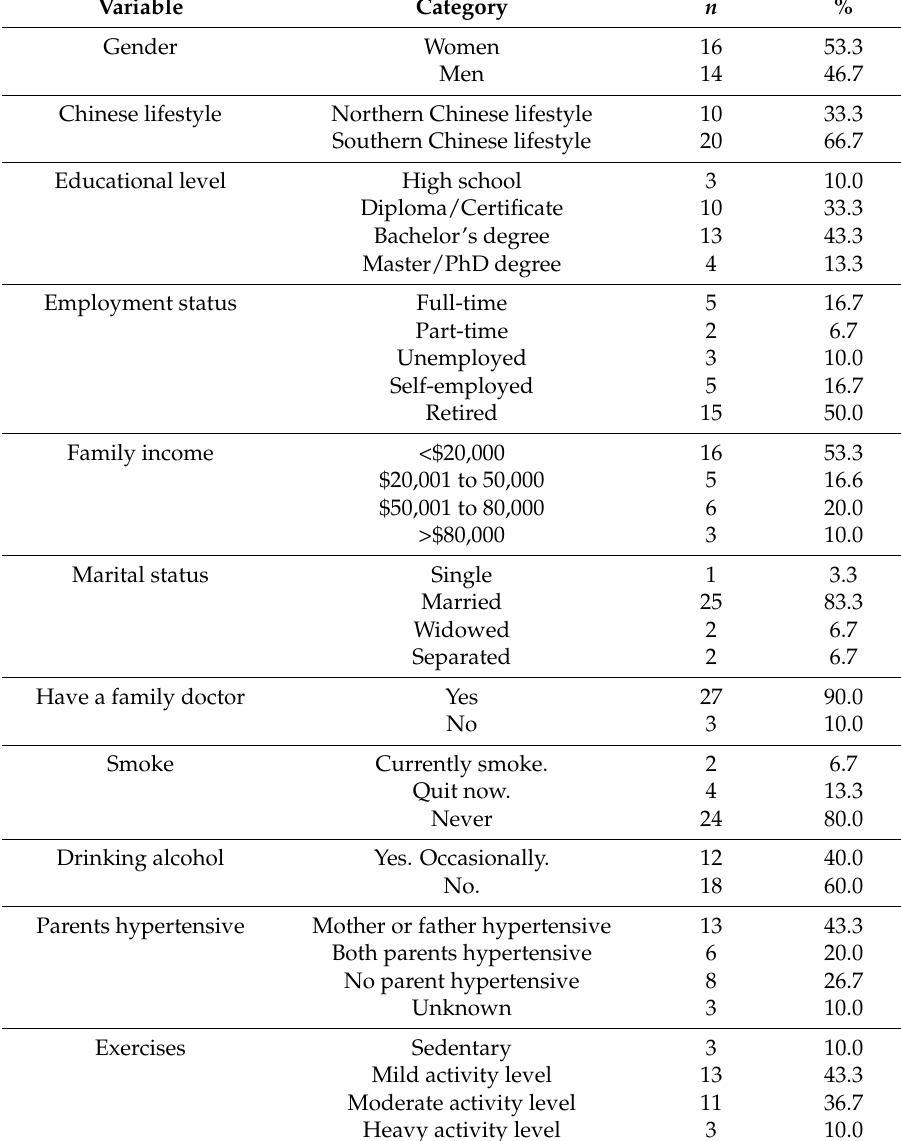
Table 1. Participant Demographic